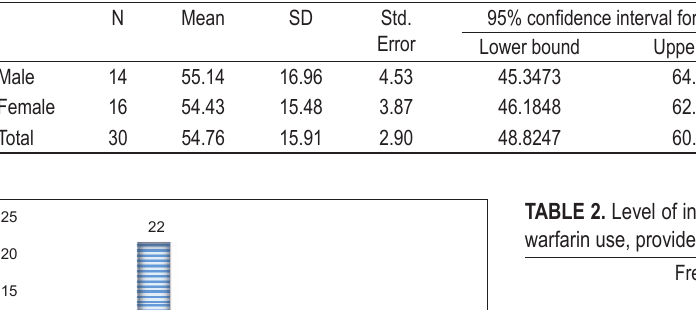
Table 1. Age and gender of subjects